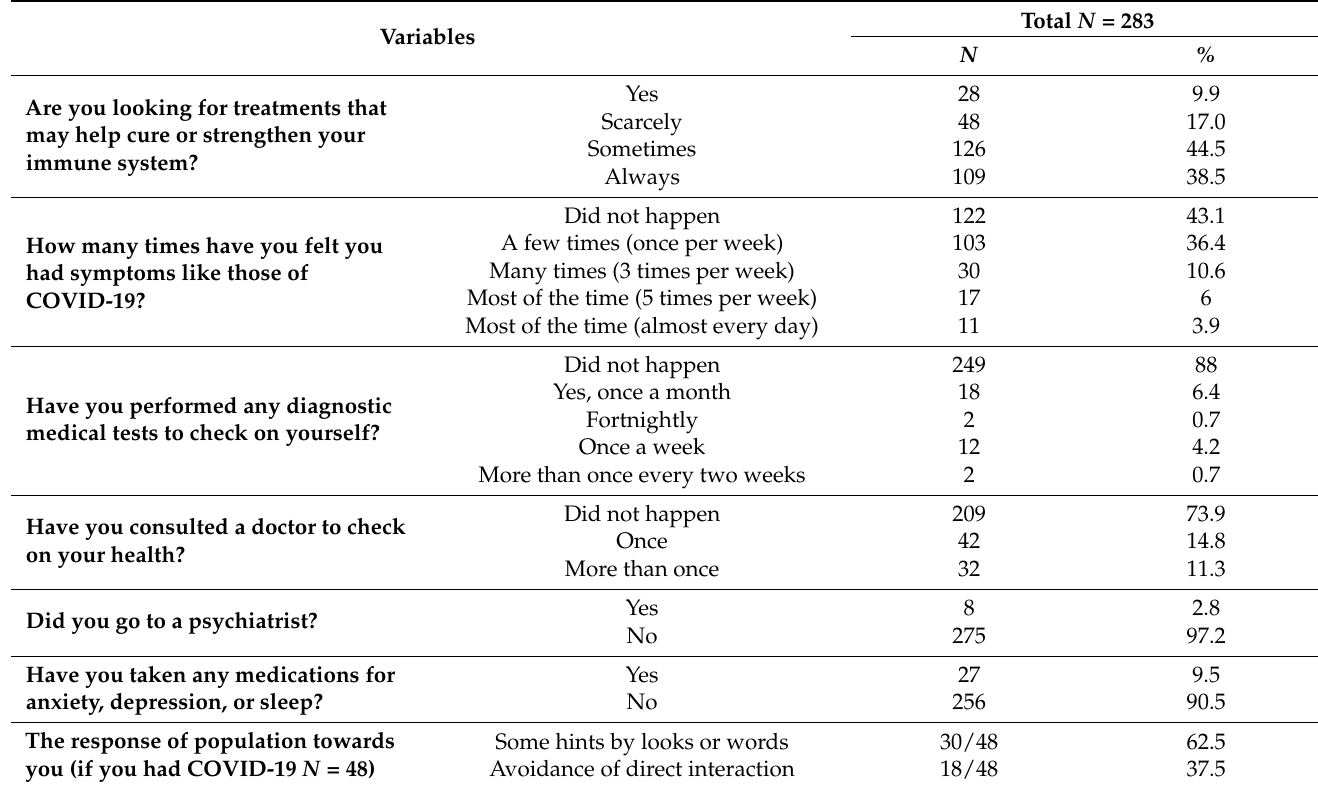
Table 2. Population attitude towards the COVID-19 pandemic. Responses to section II of the study questionnaire, which included questions about the attitudes and reactions of our sample Egyptian population towards COVID-19. Data are expressed as numbers ( N ) and percentages ( %